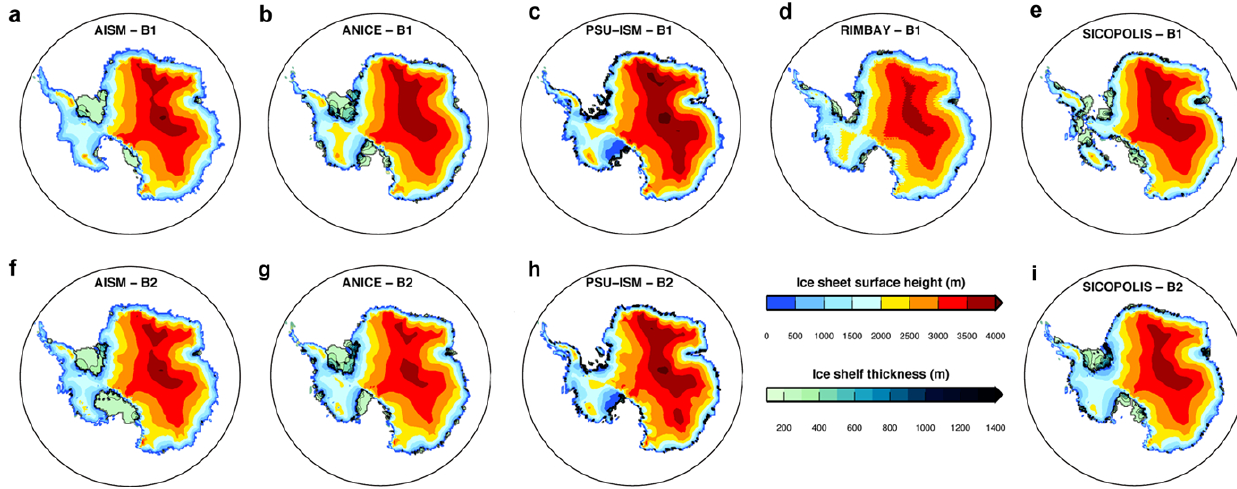
Figure 8. Ice surface topography and ice thickness of the ice shelves for the Pliocene PD-Ant simulations with HadAM3 Pliocene climate forcing except a modern Antarctica. All models are initialised with their own Control HadCM3 final ice sheet (Fig. 3). (a) – (e) show simu- lations with Bedmap1, (f) – (i) show simulations with Bedmap2. For all panels the colour scale is the same as in Fig. 3. (a, f) AISM-VUB, (b, g) ANICE, (c, h) PSU-ISM, (d) RIMBAY, (e, i)